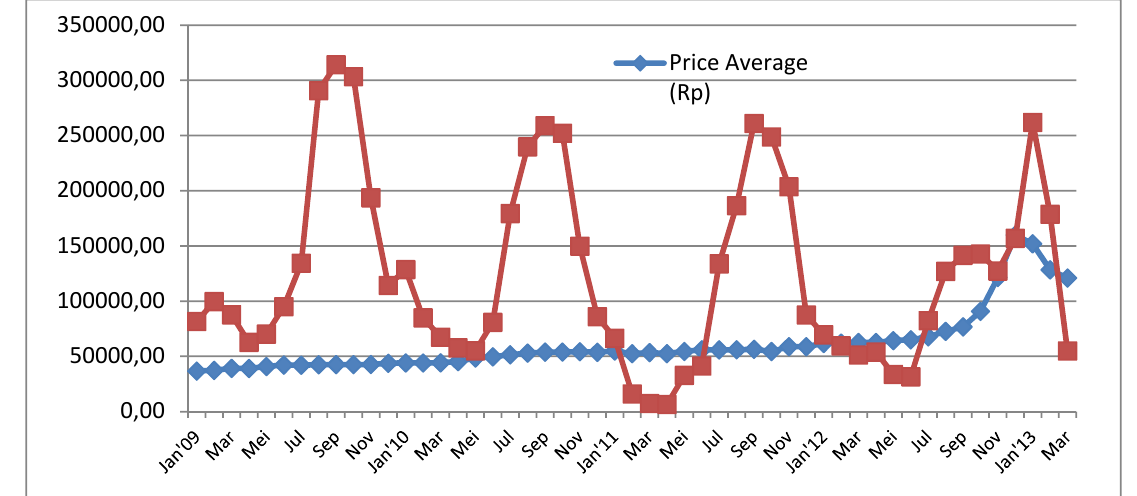
Fig. 1. The price and the number of